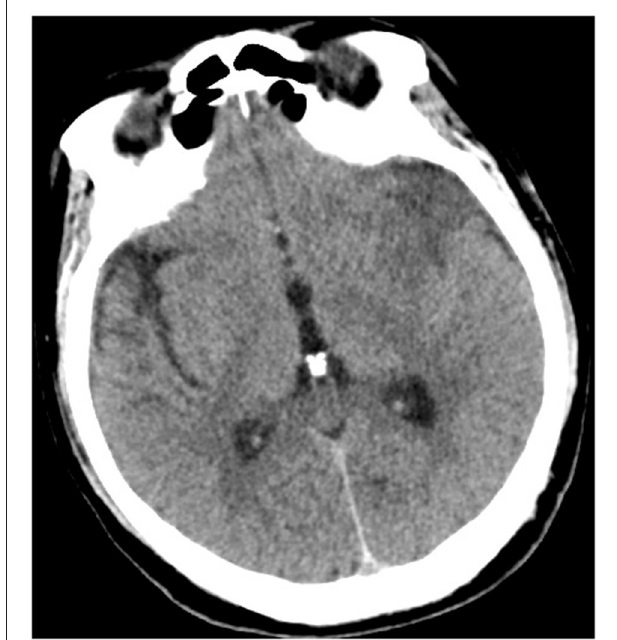
FIGURE 1 | Initial head CT revealed left frontal lobe and left insular lobe hypodensities.